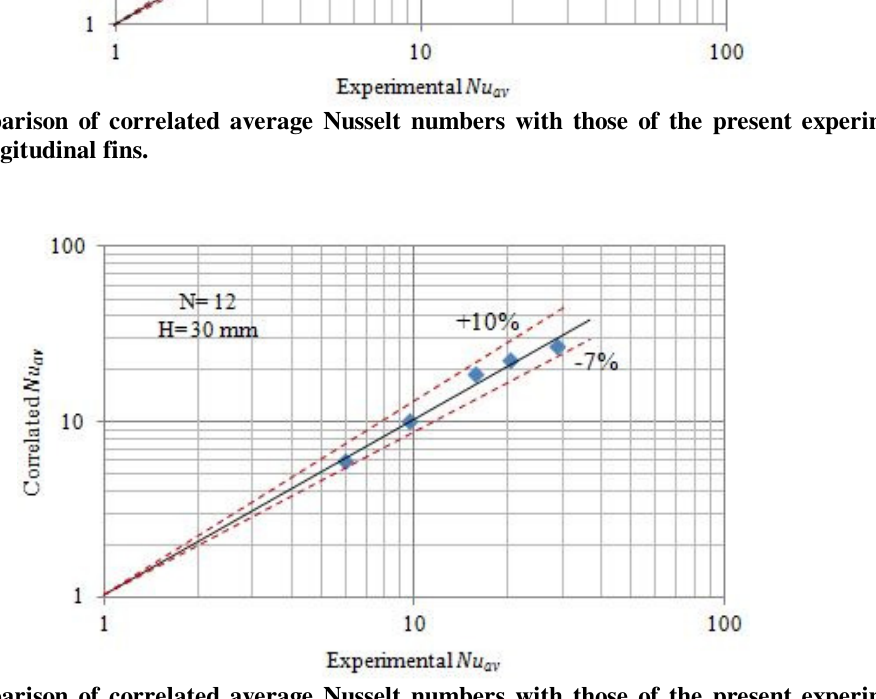
Fig. 11. Comparison of correlated average Nusselt numbers with those of the present experimental work for interrupted longitudinal